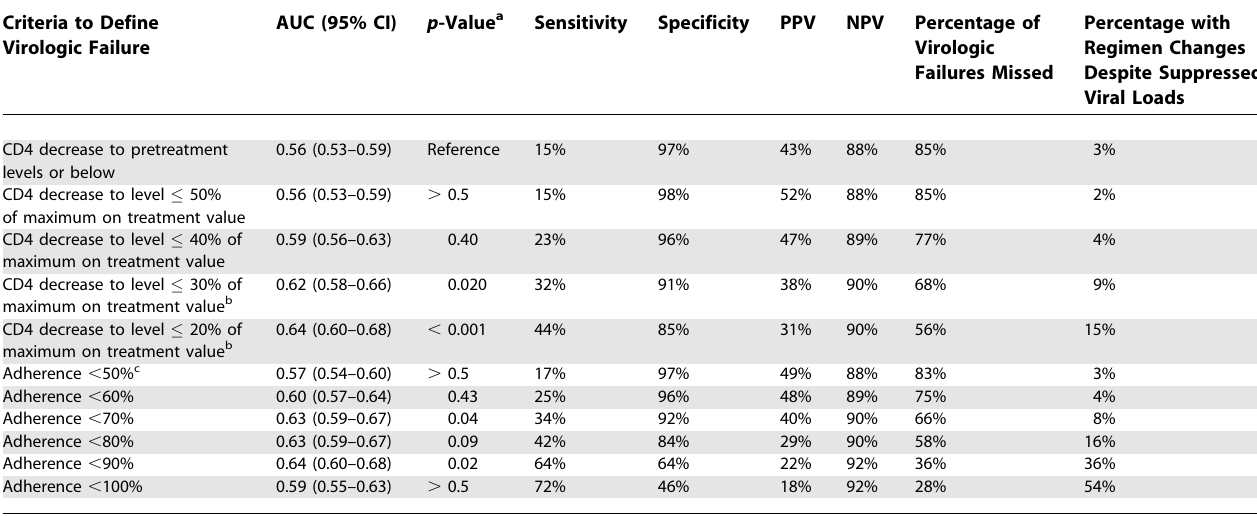
Table 5. Test Characteristics for CD4 Cell Count Changes and Adherence Levels for Identifying Patients with Breakthrough Virologic Failure after Initial Response to cART ( n ¼